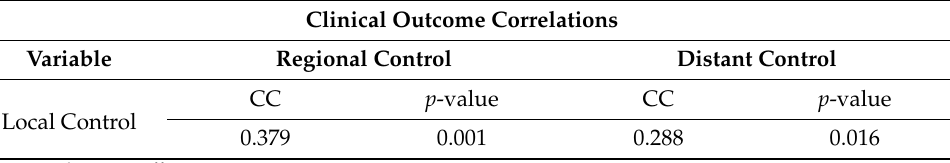
Table 4. This table summarizes the correlation between local and regional as well as distant (= ex- trathoracic) disease control (two-sided Pearson